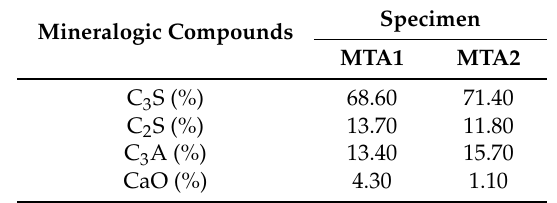
Table 2. Amount of main crystalline compounds present in MTA cements assessed by the Rietveld refinement technique.